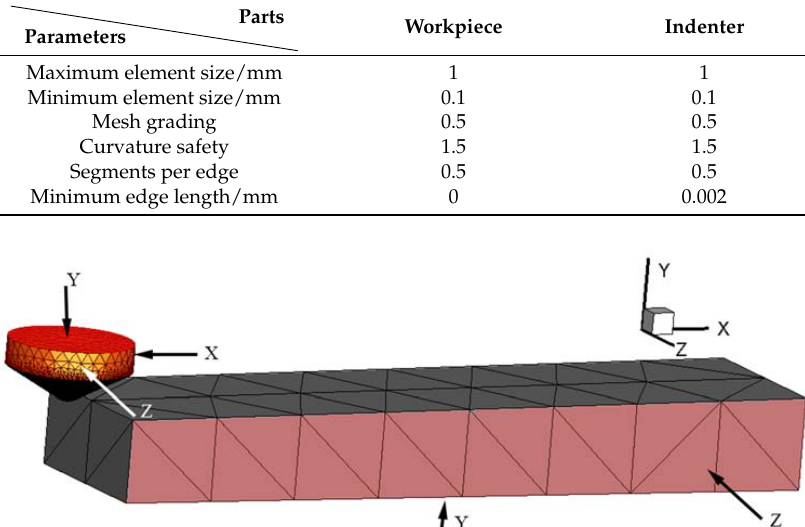
Table 5. Design of the experiment for uniaxial compression.